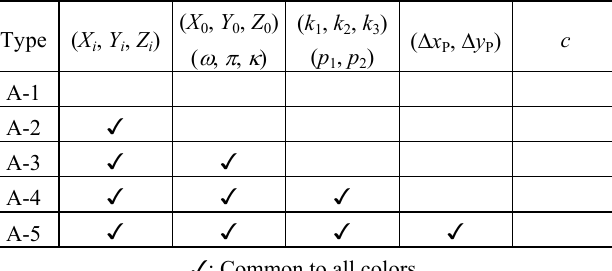
Table 1. Orientation parameters in the camera calibration of the Types A-1 to A-5